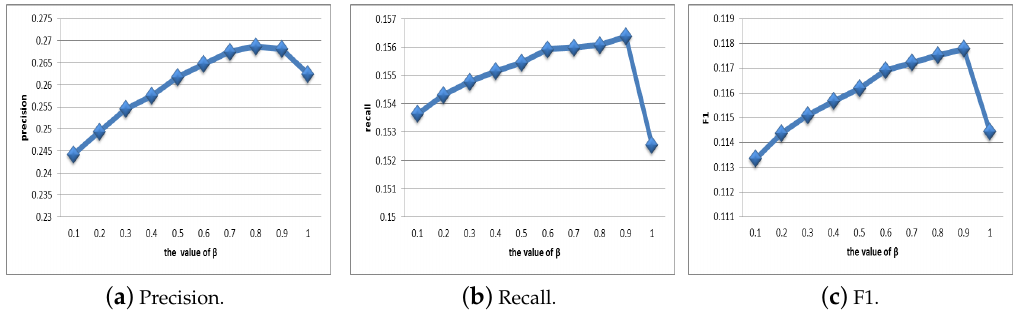
Figure 6. Selection of Parameter β . ( a ) Description of Precision in the first panel. ( b ) Description of recall in the second panel. ( c ) Description of F1 in the third panel.